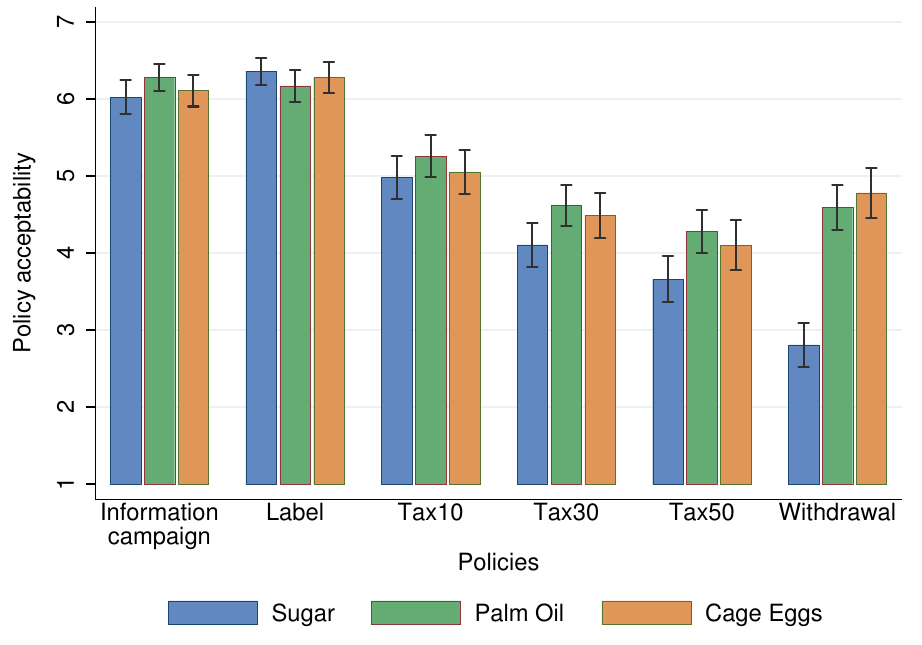
Figure A1. Reported policy acceptability—confirmatory analysis.